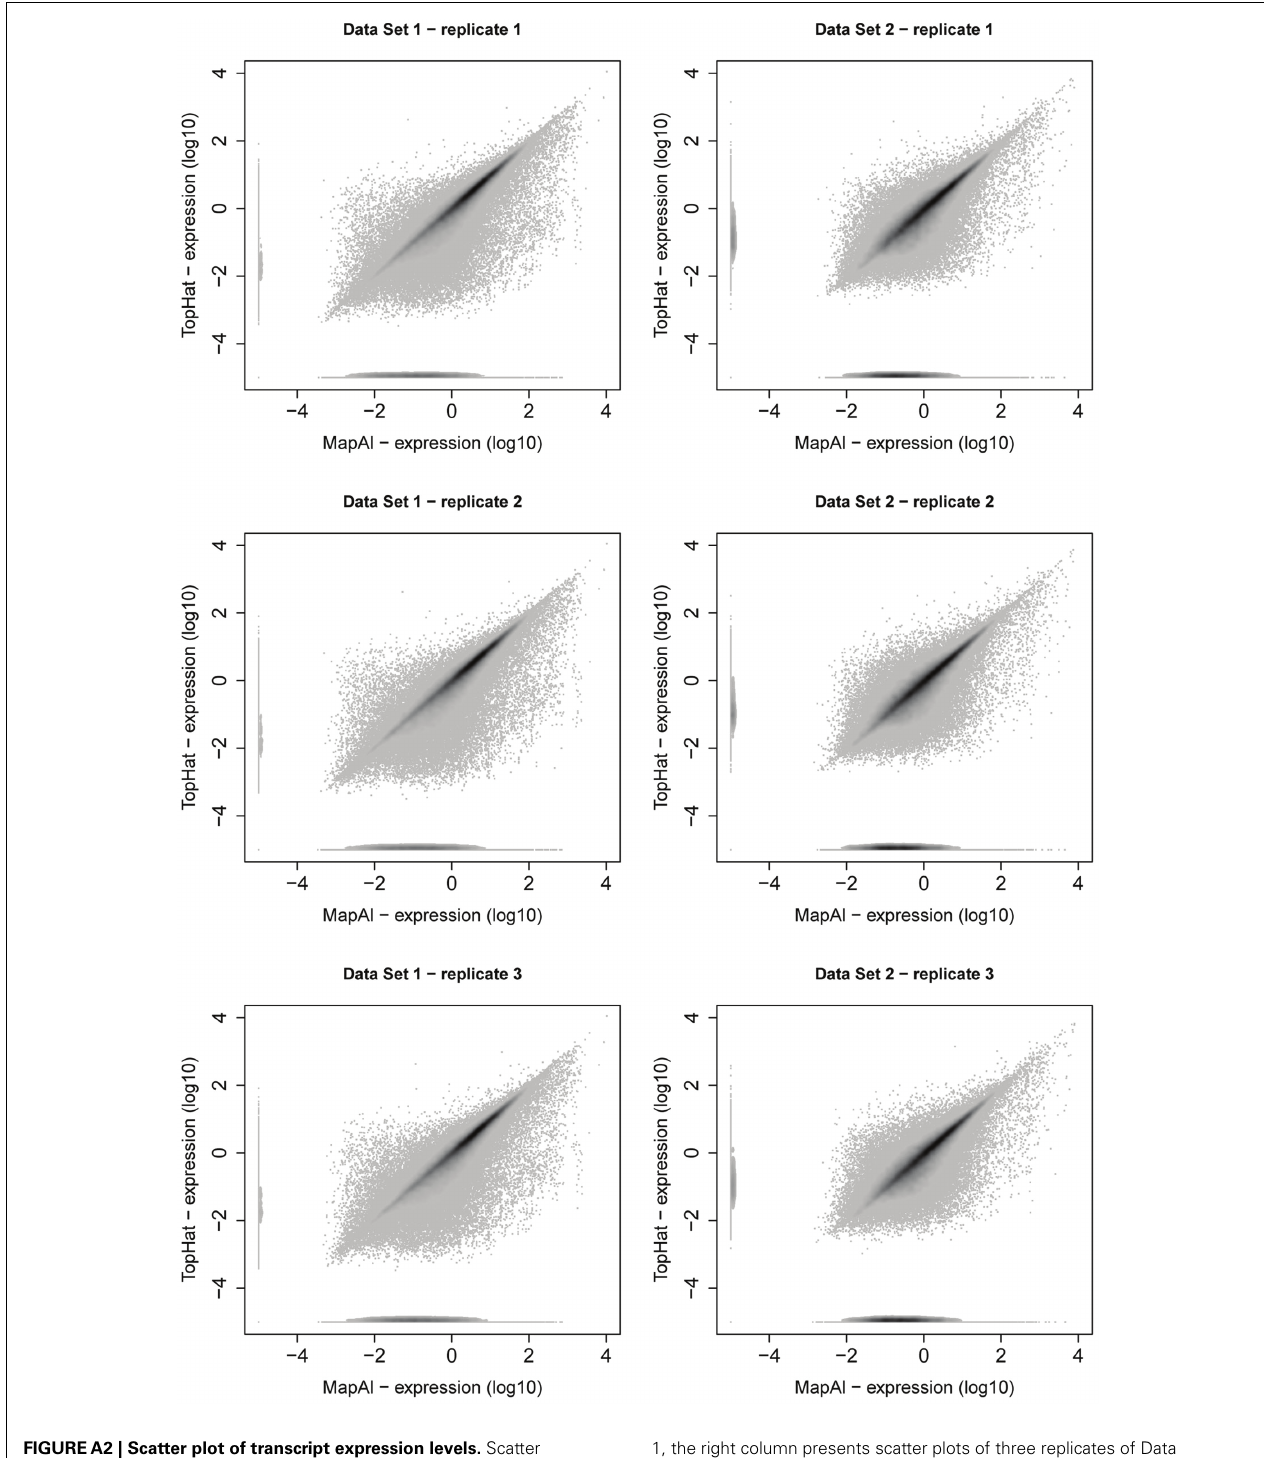
1, the right column presents scatter plots of three replicates of Data Set 2. From all scatter plots it is clear that substantial amount of transcripts are higher expressed for MapAl pipeline than for TopHat